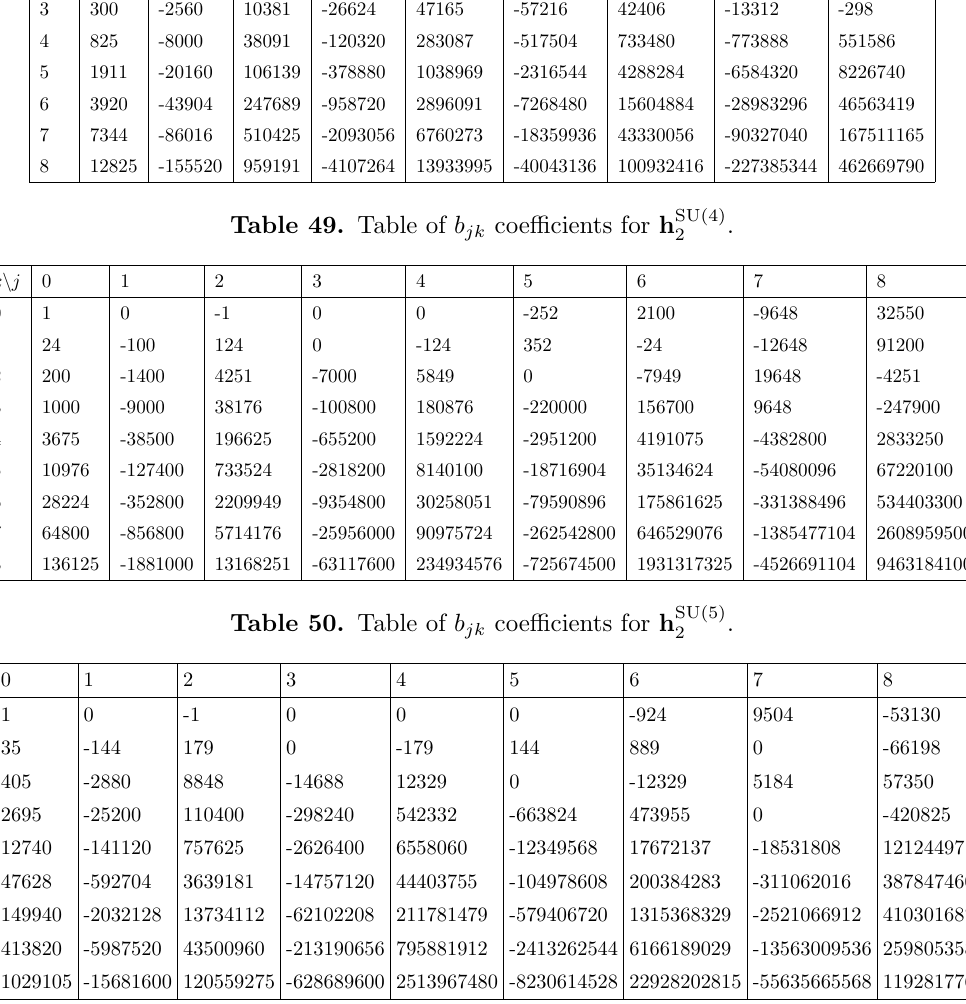
Table 51. Table of b jk coe(cid:14)cients for h SU(6)